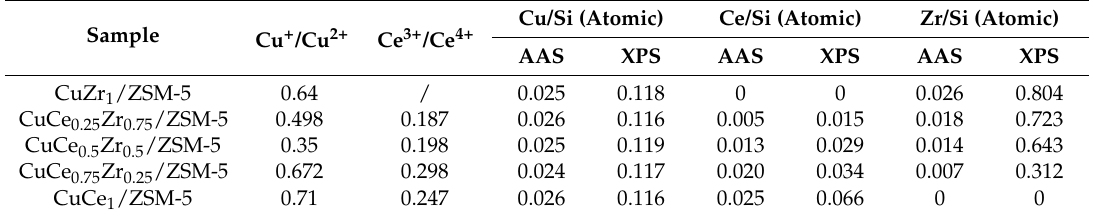
Table 1. Surface compositions of CuCe x Zr 1 − x /ZSM-5 catalysts ( x = 0, 0.25, 0.5, 0.75, 1) obtained from X-ray photoelectron spectroscopy (XPS) analysis.